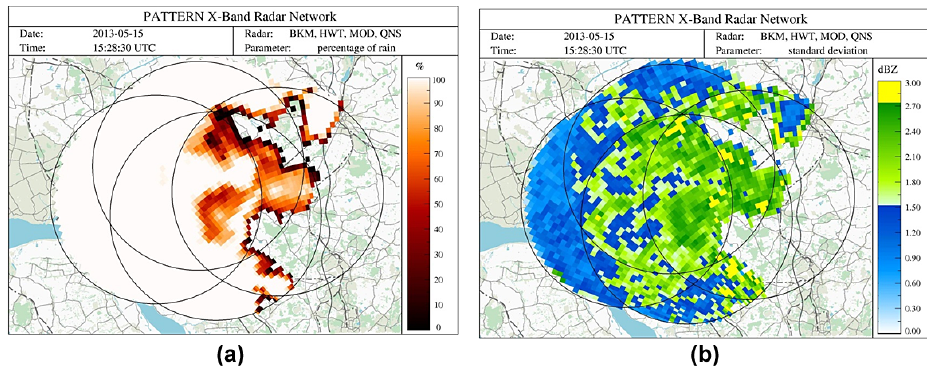
Figure 13. (a) Percentage of PATTERN network range gates with rain on the DWD grid and (b) standard deviation of reflectivity in the PATTERN network on the DWD grid for 15 May 2013,